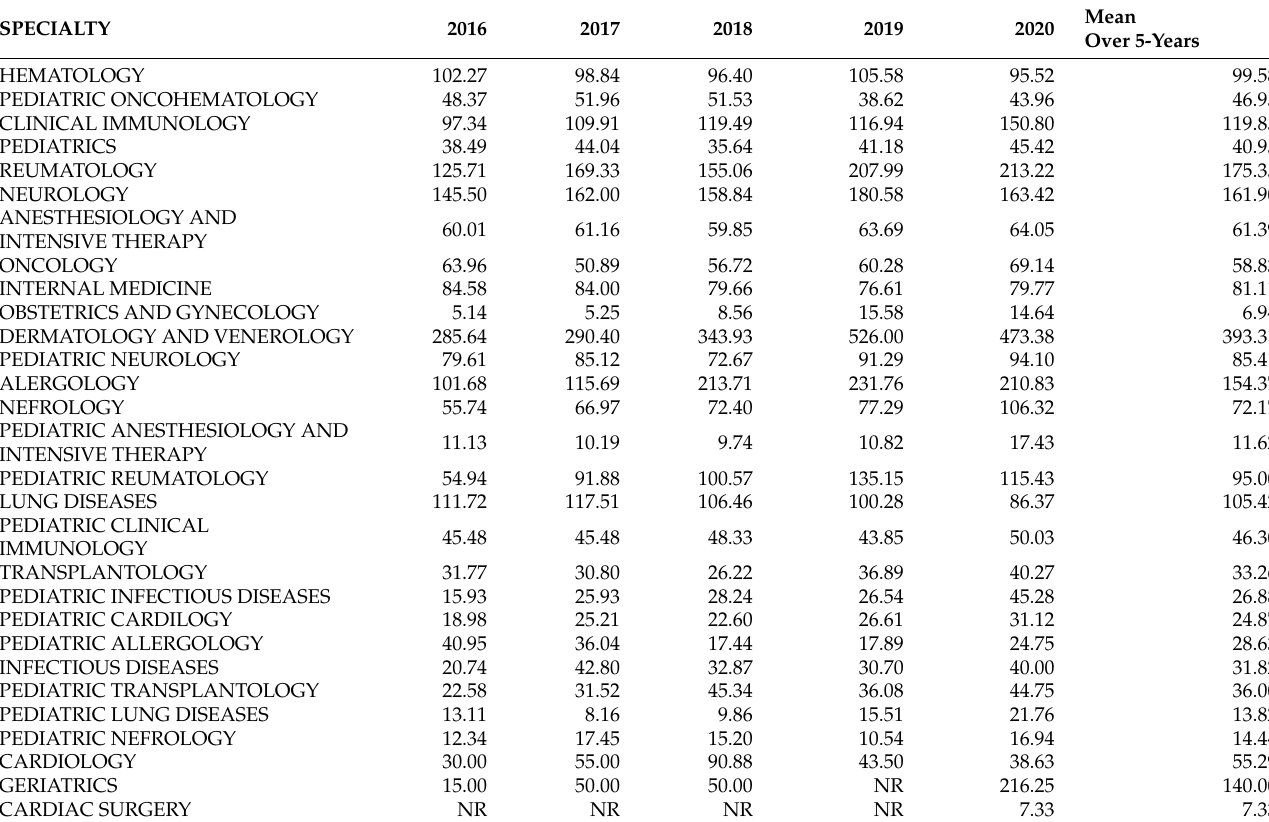
Table 2. Mean annual consumption of immunoglobulins in grams per patient from 2016 to 2020 and mean annual dose per patient over this period by specialty. NR—not